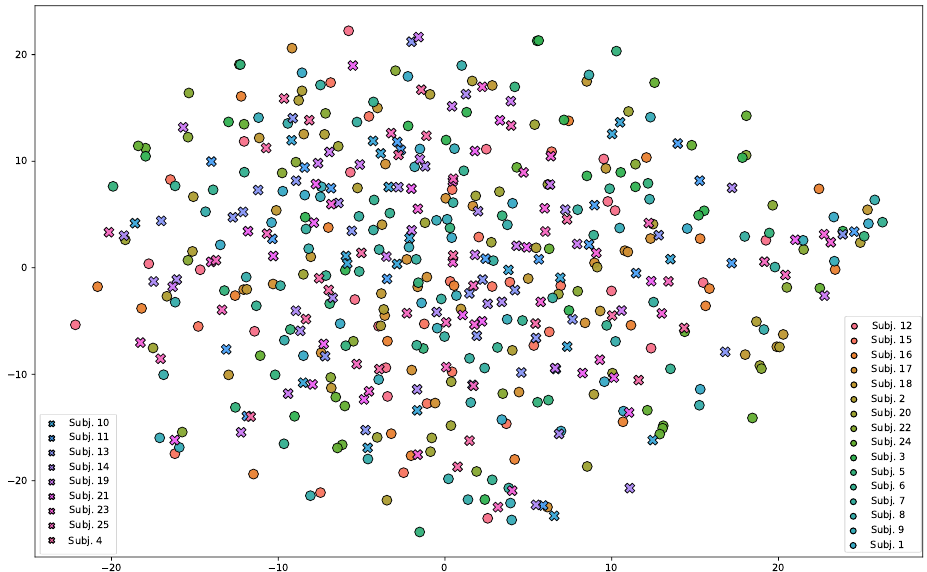
Figure 10. Two-component t-SNE representation of the Breath Meta-Dataset radar data. The circles represent the training users, while the crosses represent the testing users for the Meta-L. No user- specific feature clusters are visible under the t-SNE assumptions. The t-SNE was obtained with a perplexity of 20 and 7000 iterations